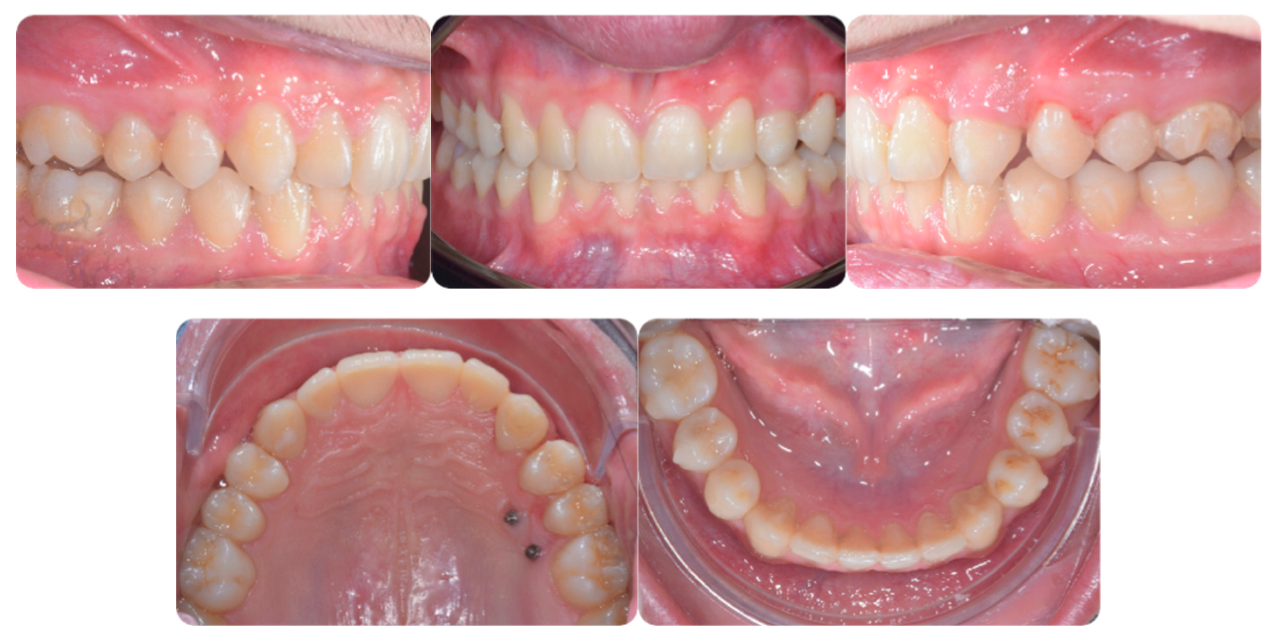
Figure 6. Progress of treatment after canine recovery and before aligner second phase.